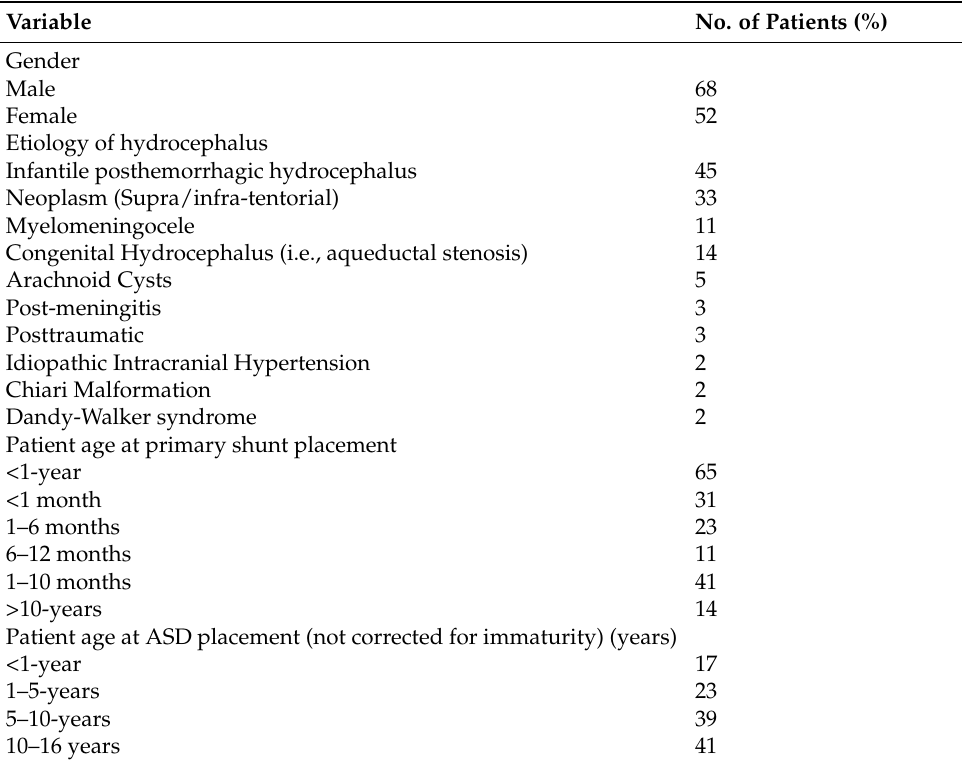
Table 1. Patient